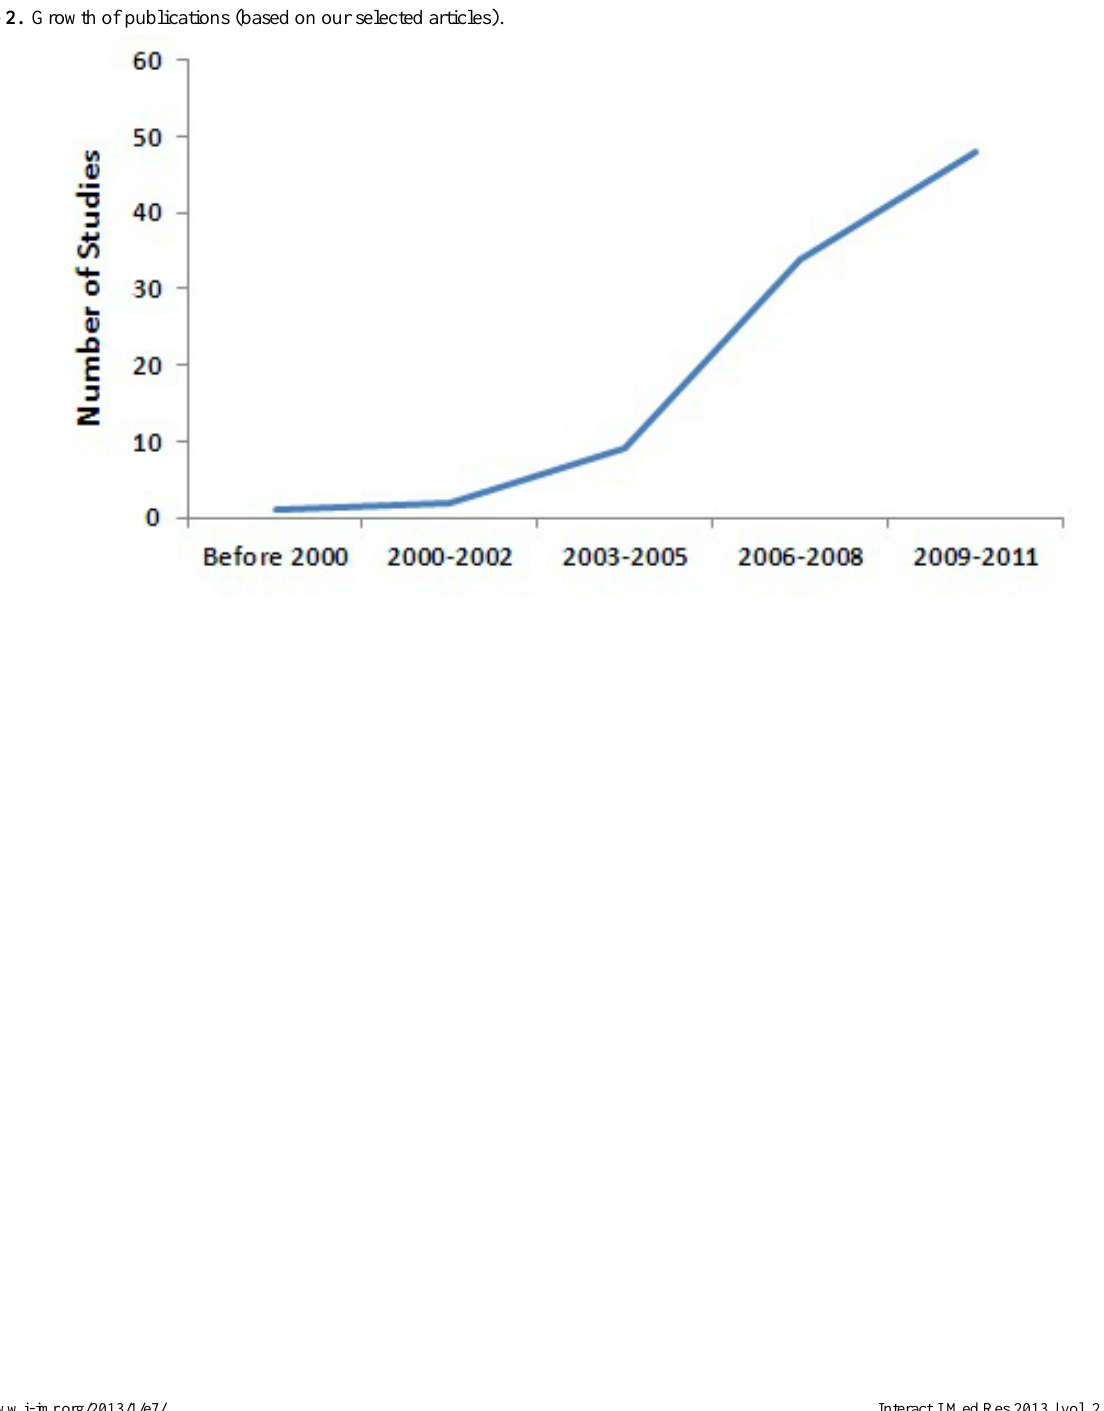
Figure 2. Growth of publications (based on our selected